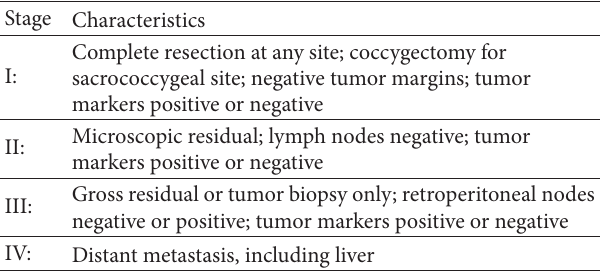
Table 1: Pediatric Oncology Group/Children Cancer Group (POG/ CCG) staging for malignant extragonadal germ cell tumors. Stage